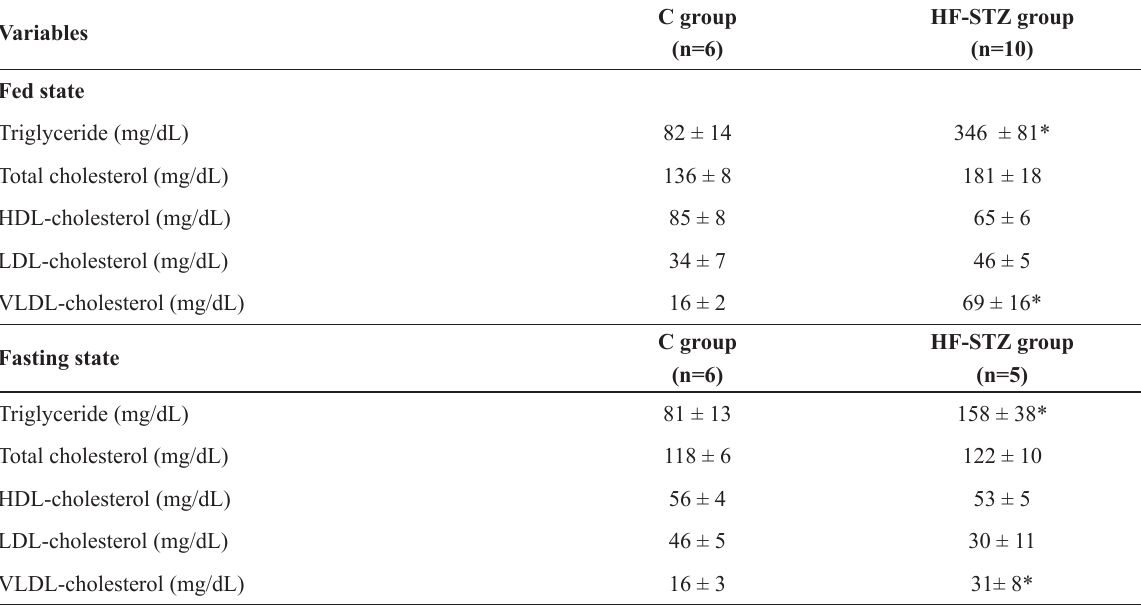
Data are expressed as mean ± standard error of the number of animals (n) indicated in parentheses. * P < 0.05 versus controls (Student’s t